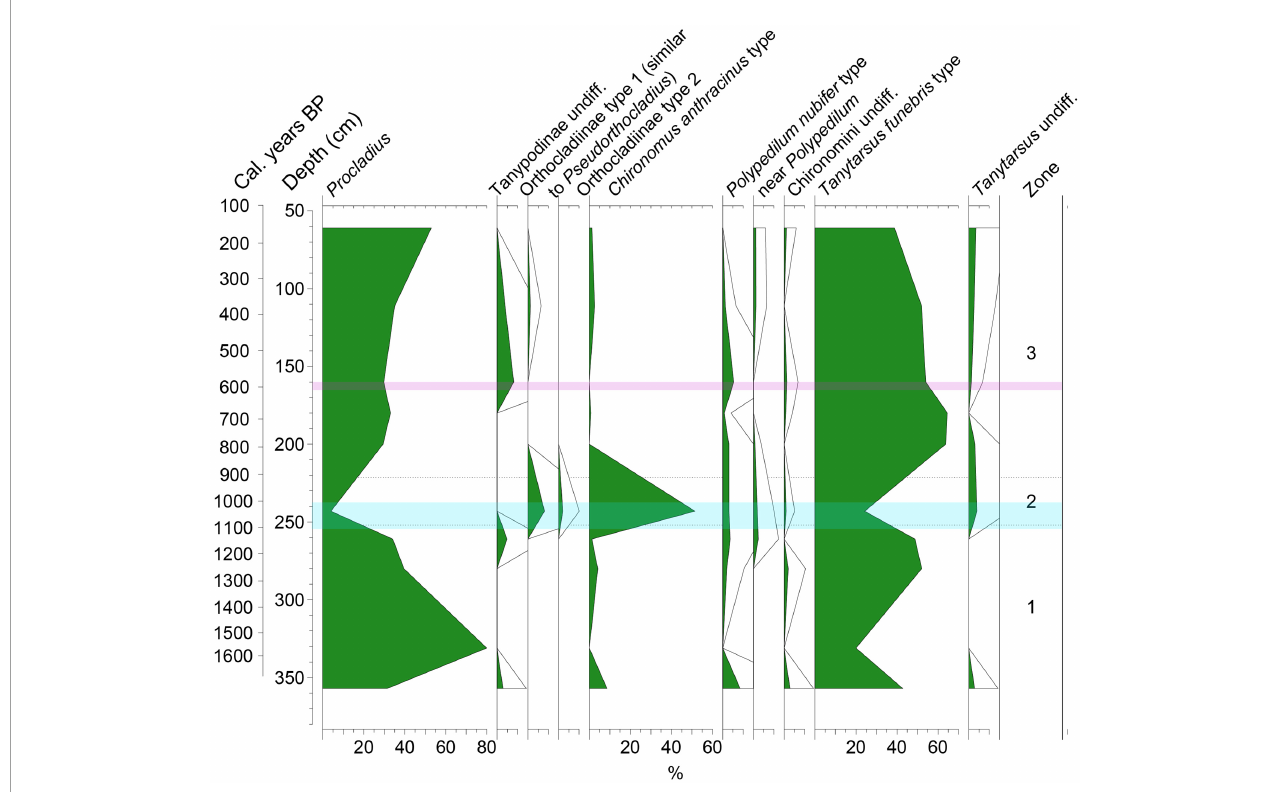
FIGURE4 Chironomid percentage diagram, the period of climate transition from wetter to drier is shown in pale blue and the Kuwae tephra is shown as a purple shaded area.